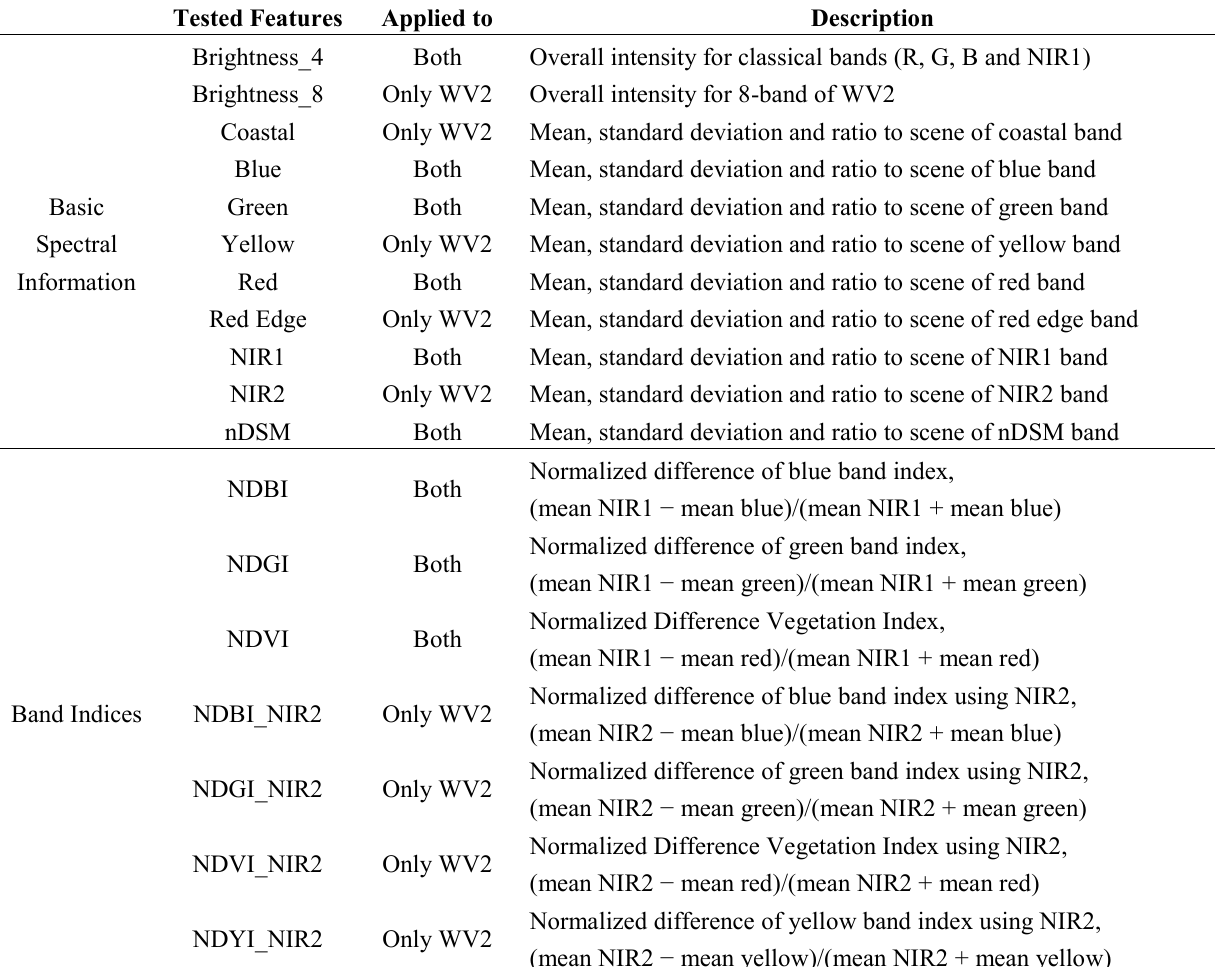
Table 3. Image object features based on basic spectral information and band indices used in the classification phase. The NIR band of GE1 is expressed as